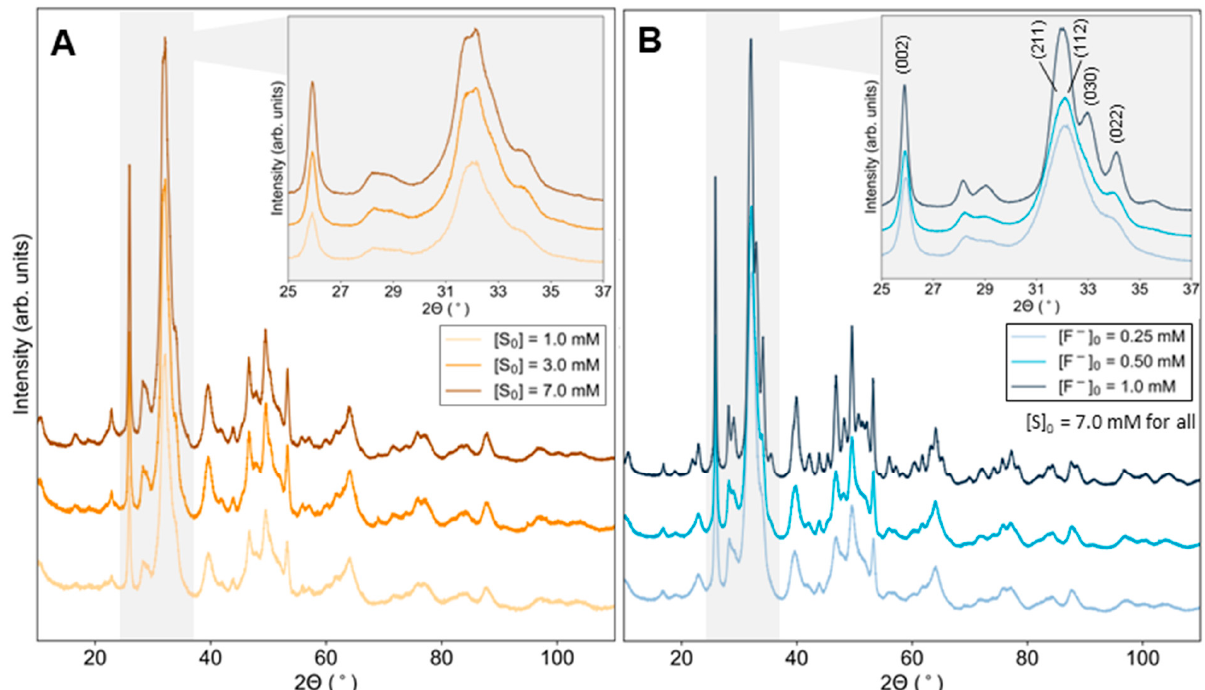
Figure 2. X-ray powder diffraction patterns for substituted HAP synthesized via homogeneous enzymatic catalysis at 37 ◦ C, pH 7.4 ( A ) at variable concentrations of substrate, [S] 0 = 1.0, 3.0 and 7.0 mM, or ( B ) at [S] 0 = 7.0 mM and variable concentrations of fluoride ions, [F − ] 0 = 0.25, 0.50 and 1.0 mM.